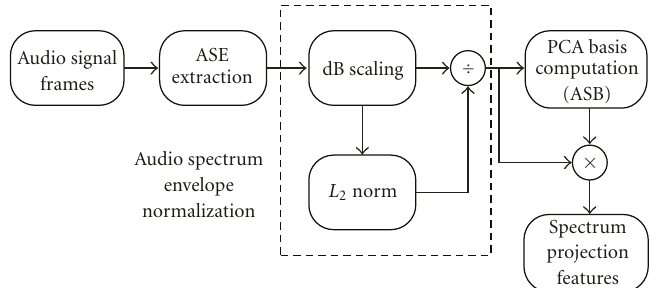
Figure 2: Block Diagram of ASP extraction.